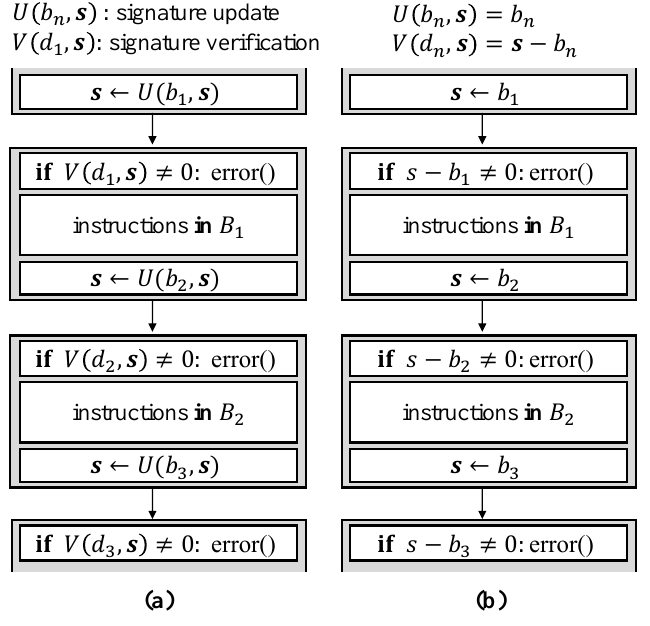
Figure 2. ( a ) Typical model of signature-based CFE monitoring scheme; and ( b ) the simplest case of signature-based CFE monitoring